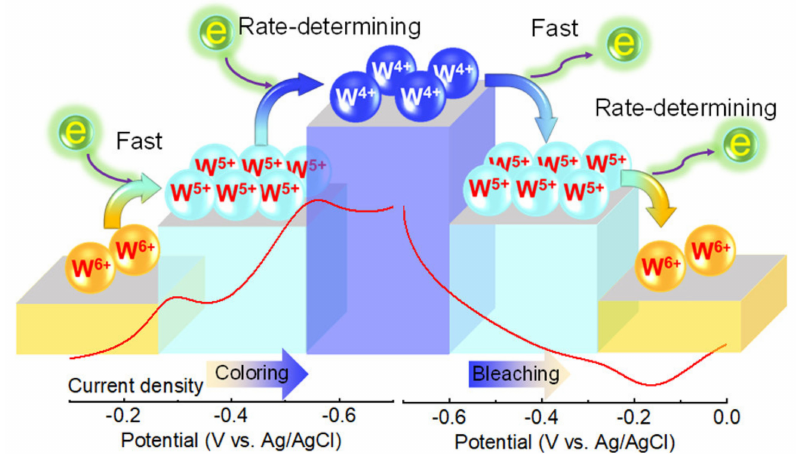
Figure 1. Diagram showing the rate-determining step in the continuous electron-transfer process [9]. [Reprinted with permission from Ref. [9] Copyright {2021} American Chemical